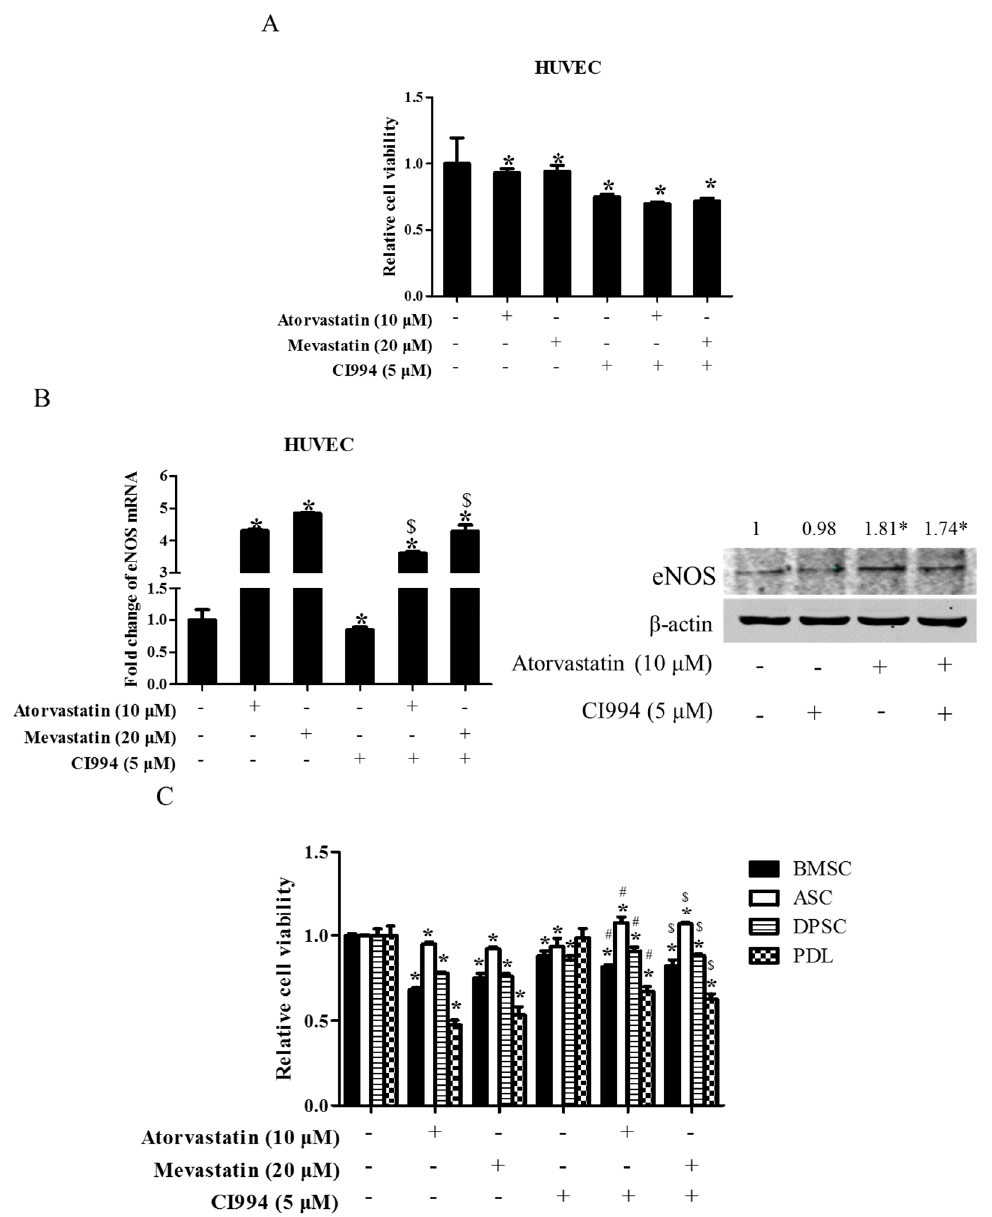
Figure 7. HDAC1 inhibitor did not enhance statin-induced inhibition of cell proliferation in non-tumor primary cells. HUVEC cells were exposed to either statin (mevastatin 20 μ M/atorvastatin 10 μ M), or CI994 (5 μ M), or both 48 h. Cell viability was assessed by a CCK8 assay ( A ); Expression of eNOS was analyzed by real-time PCR and Western blot ( B ); * P < 0.05 vs. the control group; $ P < 0.05 vs. CI994 group, n = 3. Non-tumor primary cells (BMSC, DPSC, PDL, ASC) were exposed to either statin (mevastatin 20 μ M/atorvastatin 10 μ M), or CI994 (5 μ M), or both for 48 h. Cell viability assessed by CCK8 assay ( C ); * P < 0.05 vs. the control group; # P < 0.05 vs. mevastatin group; $ P < 0.05 vs. atorvastatin group, n = 4.